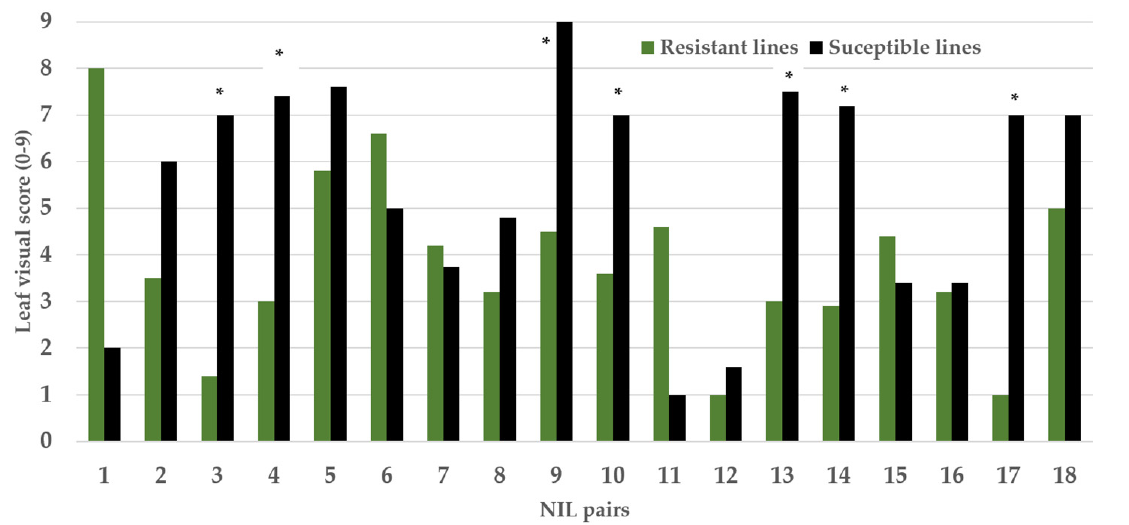
Figure 2. Eighteen pairs of putative near-isogenic lines (NILs) derived from F 2 single-seed descent progenies conferring metribuzin resistance in the Chuan Mai 25 × Ritchie population were assessed with the plant leaf visual score (0–9: score 0 is the most resistant and score 9 means most susceptible), which was taken on the 12th day of metribuzin application. Lines with the resistant molecular marker are green, and lines with the susceptible molecular marker are black. Confirmed NILs are marked with *.